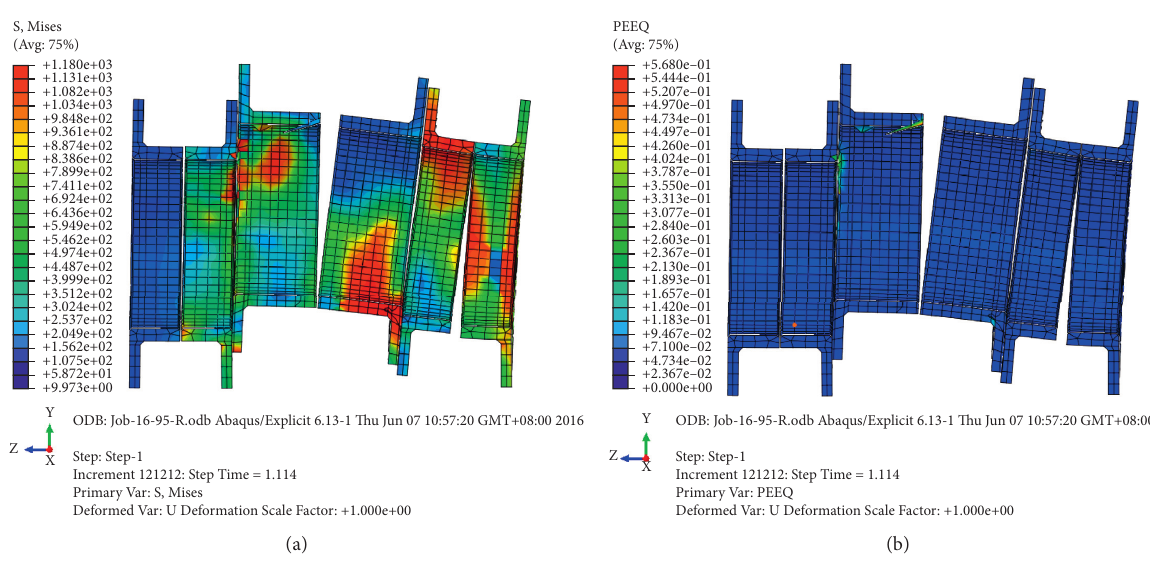
Figure 18: Equivalent stress contour of bushing at and after the point of failure. (a) Separation point. (b) After